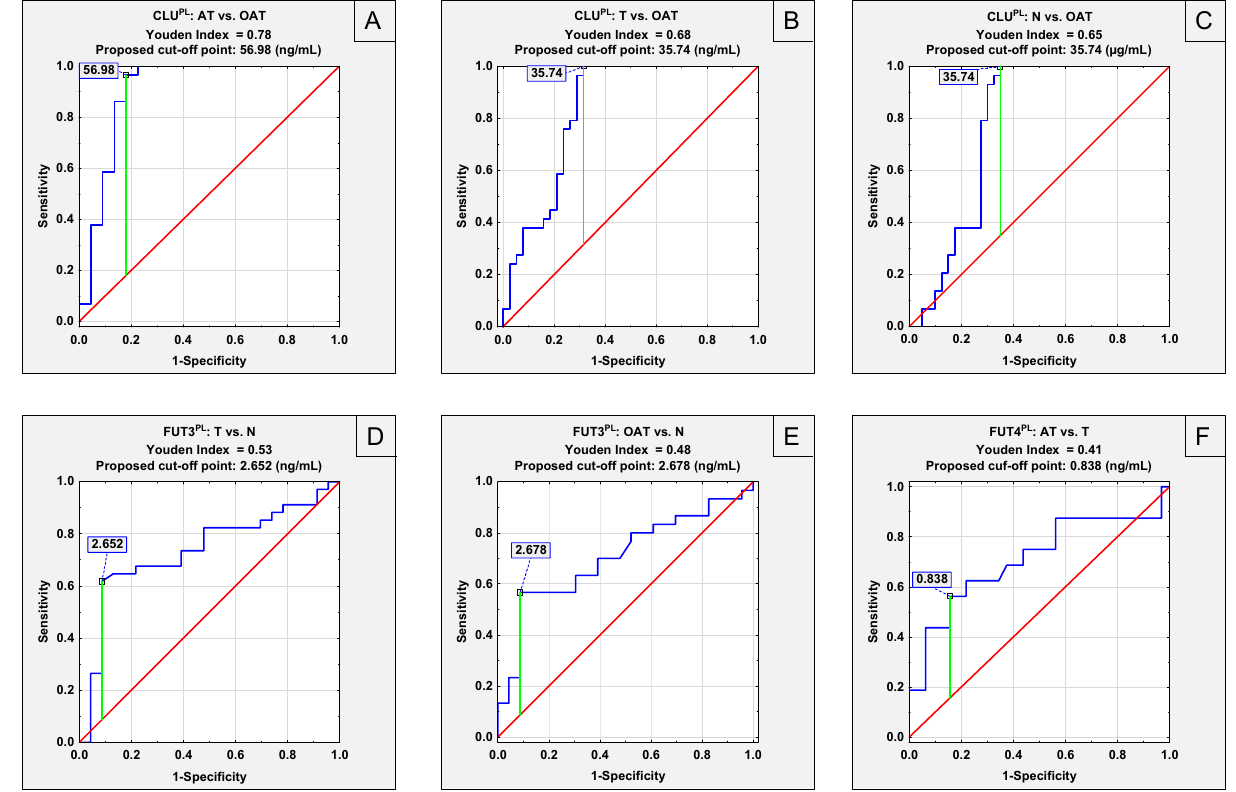
Figure 3. Receiver operating characteristic (ROC) curves for seminal plasma parameters with the area under the curve (AUC) higher than 0.700 ( A–F ). CLU PL —seminal plasma CLU concentration; FUT3 PL —seminal plasma FUT3 concentration; FUT4 PL —seminal plasma FUT4